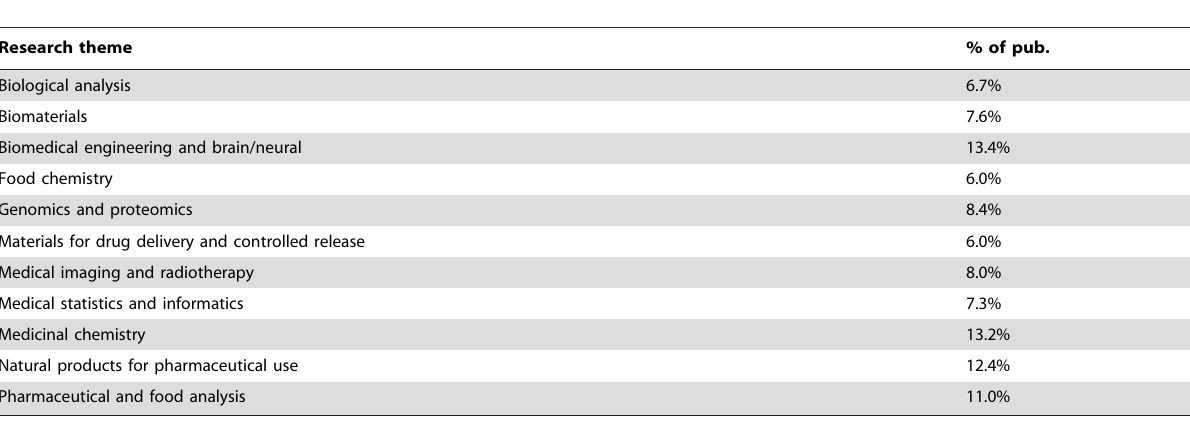
Table 5. The 11 broad research themes at the EPS-HLS interface.